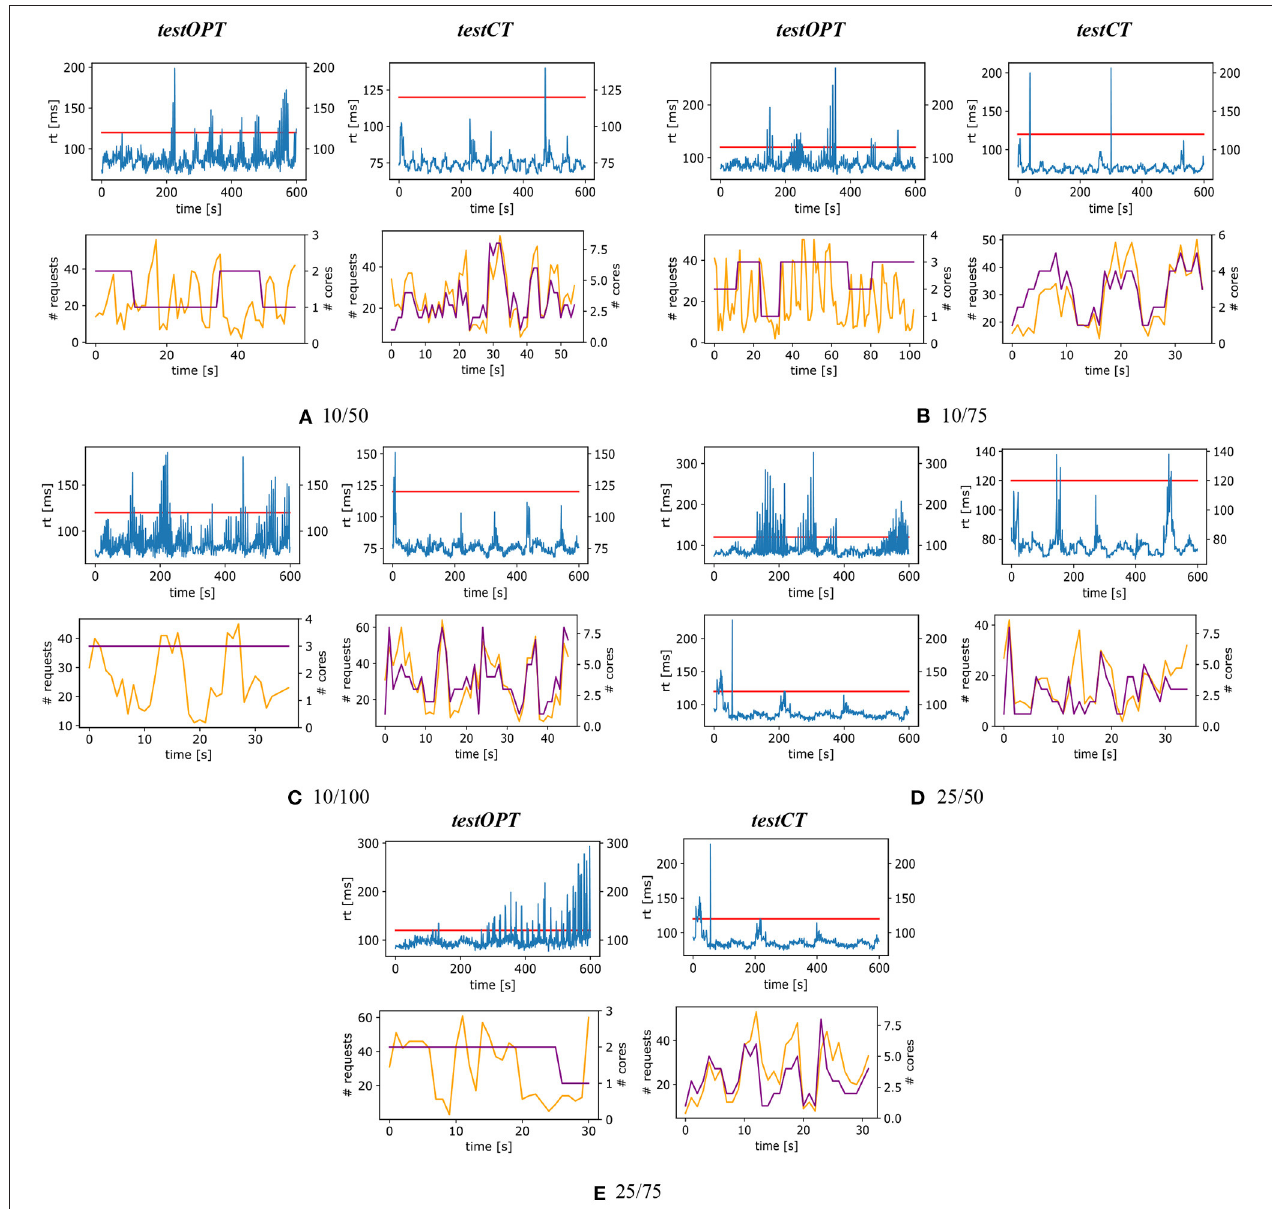
FIGURE 7 | testOPT and testCT with configurations 10 / 50 (A) , 10 / 75 (B) , 10 / 100 (C) , 25 / 50 (D) , and 25 / 75 (E) .